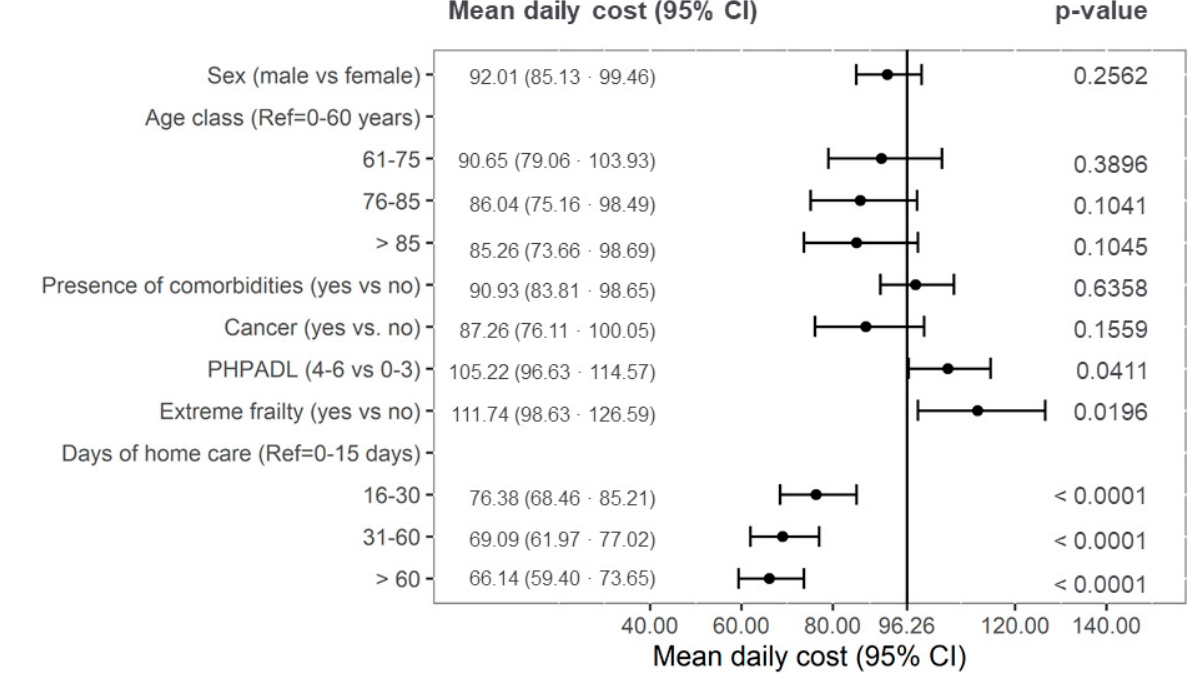
Figure 2. Multivariable analysis on factors involved in determining the mean daily costs in euro (the line represents the daily mean costs in the null model. All analyses have been adjusted for study